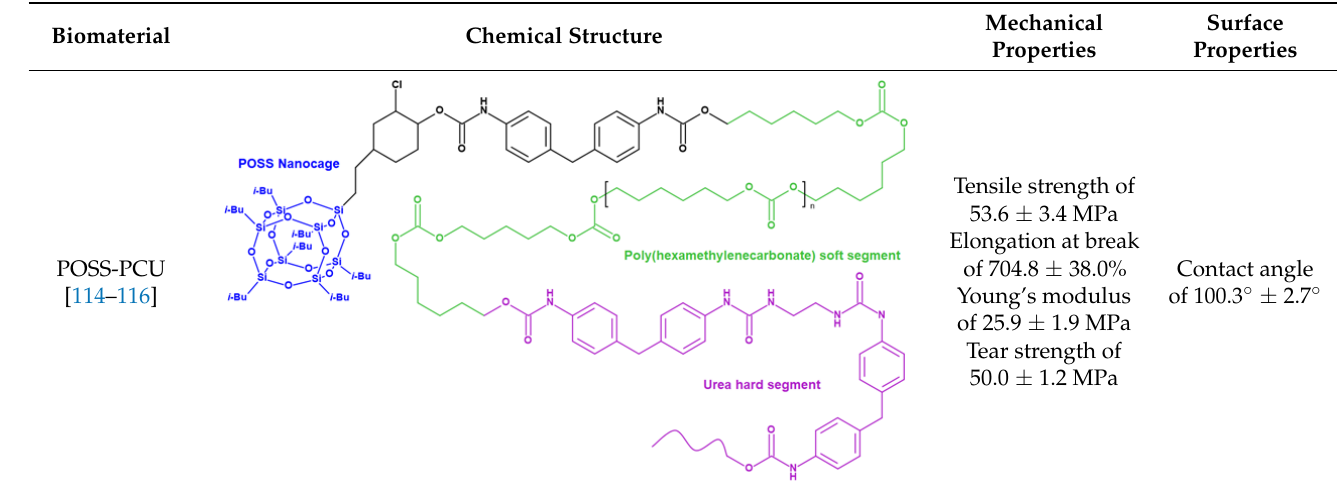
Table 1. Physical and mechanical properties of novel polymeric materials. Biomaterial Chemical